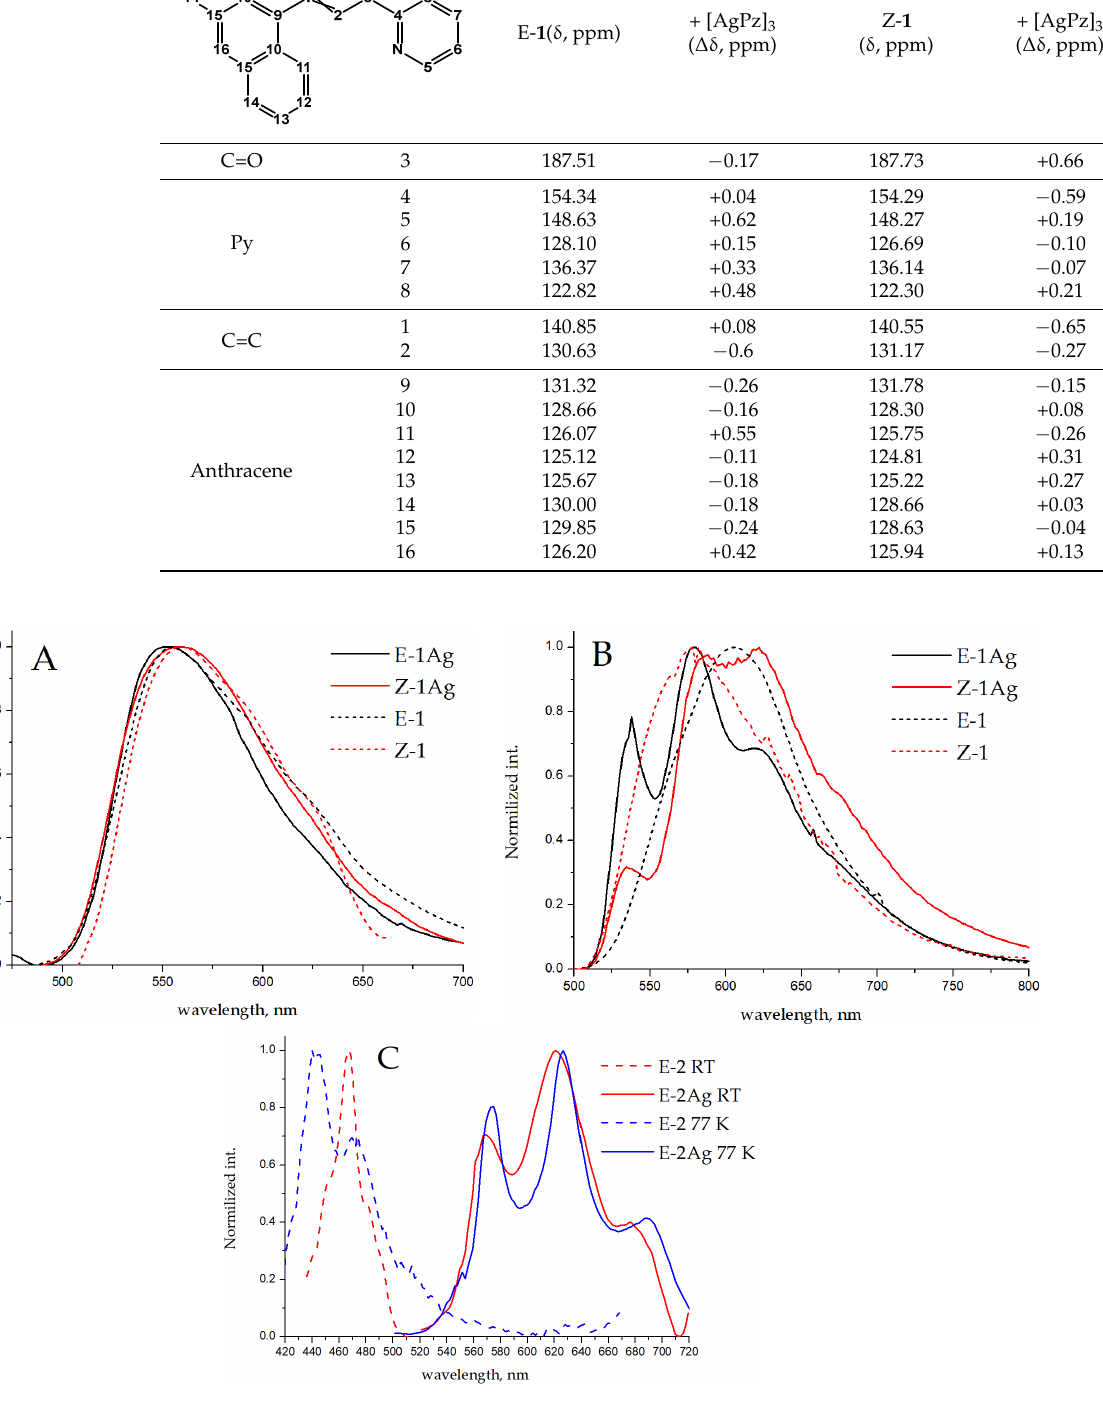
Figure 7. Normalized emission spectra of the solid samples ( λ exc = 340 nm) E- 1 , Z- 1 (dashed lines) and their complexes E-1Ag, Z-1Ag (solid lines) at 298 K ( A ) and 77 K ( B ). Normalized emission spectra of the solid samples ( λ exc = 340 nm) E- 2 (dashed lines) and E-2Ag (solid lines) at 298 and 77K ( C